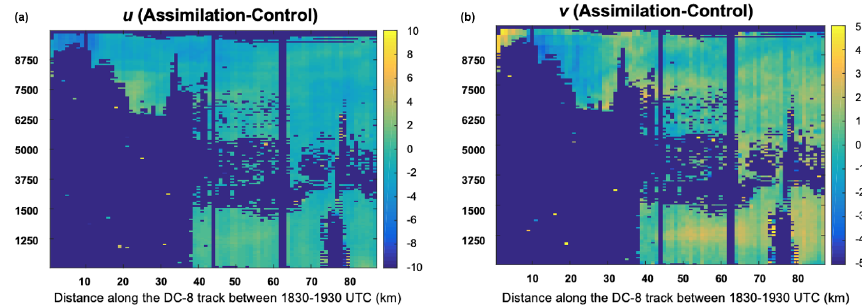
Figure 13. Profile of the analysis increment (assimilation run at 19:00UTC minus the control run at 19:00UTC) of the (a) zonal ( u ) and the (b) meridional ( v ) wind components of the flow along the DC-8 flight track as shown in Fig. 3 (top left panel). Units: ms − 1 .